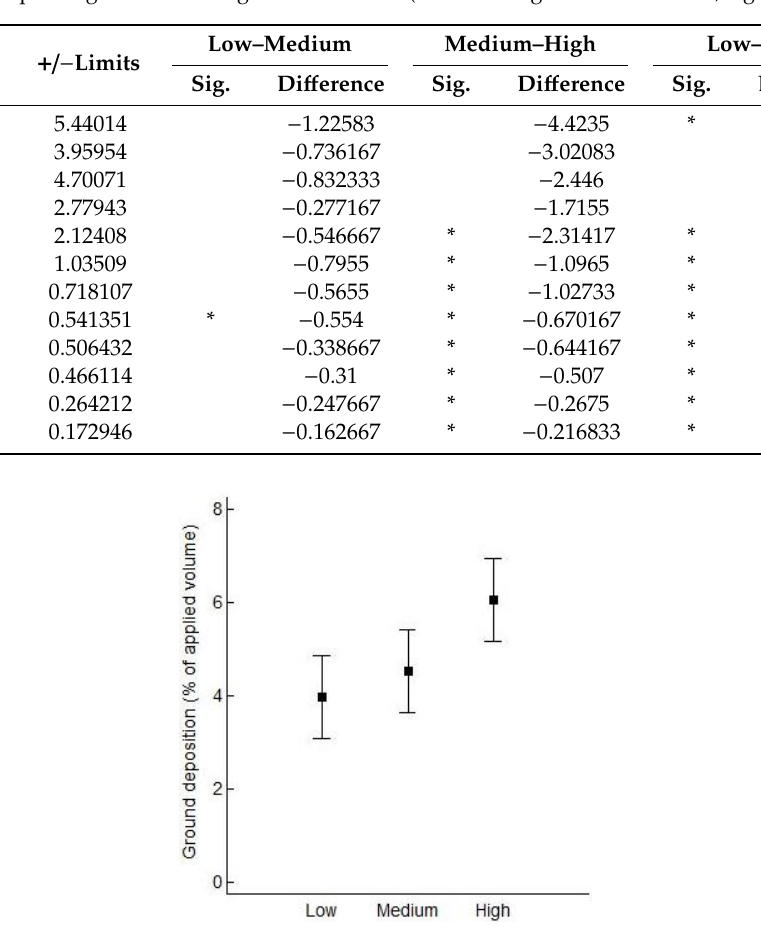
Table6. Multiple rangeLSD tests forgroundcollectors (LSD: leastsignificant di ff erence; Sig: significant).